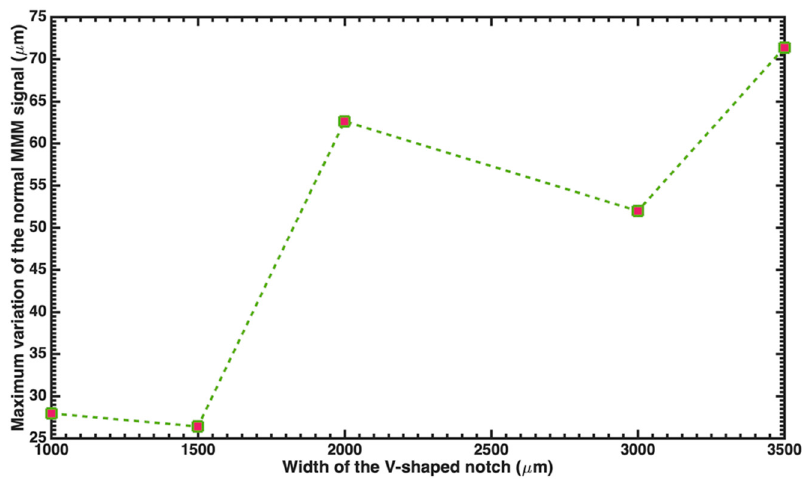
Figure 14. Maximum variation of normal MMM signals versus width of the V-shaped notch of the ASTM-A36 steel pipe. Table 2. Maximum and minimum values of tangential and normal MMM signals around the center and edges of the five V-shaped notches of an ASTM-A36 steel pipe.